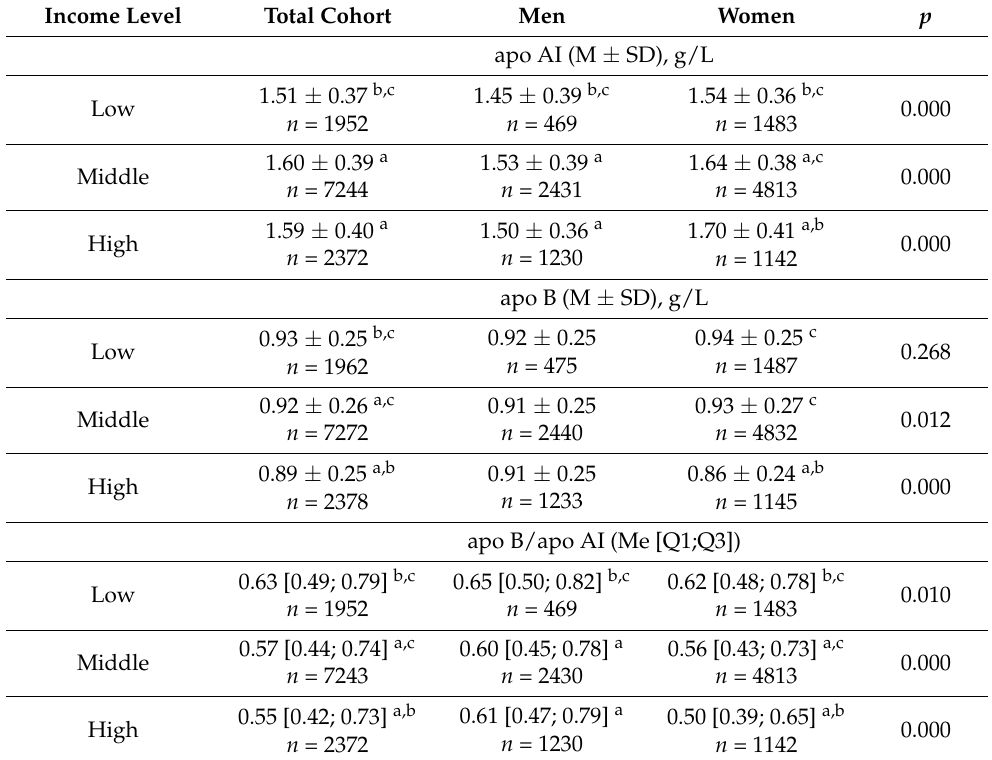
Table 4. Lipoprotein profile parameters in men and women differing in income level among popula- tions from regions of the Russian Federation: ESSE-RF study. Income Level